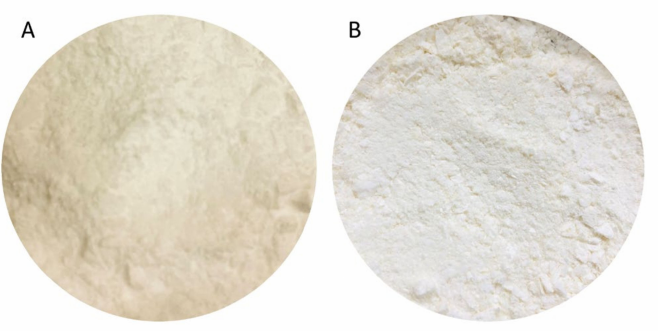
Figure 9. Images of the physical appearance of the transfersomes at ( A ): day 0 and ( B ): 6 months stored at room temperature (25 ◦ C and at ambient